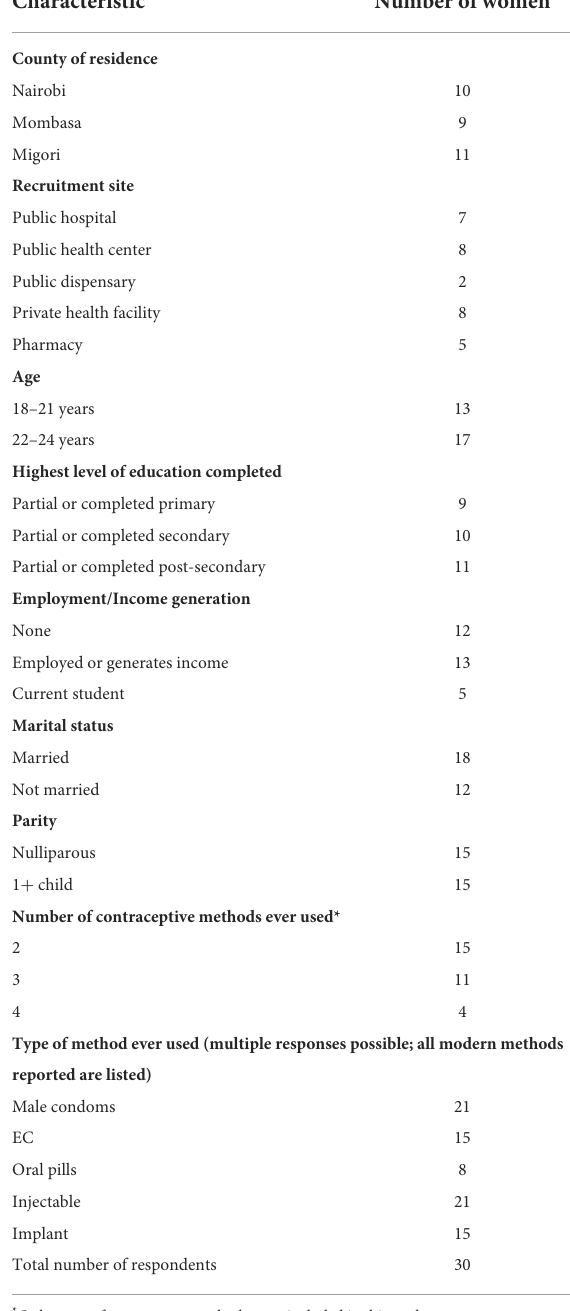
TABLE 1 Participant characteristics at time of